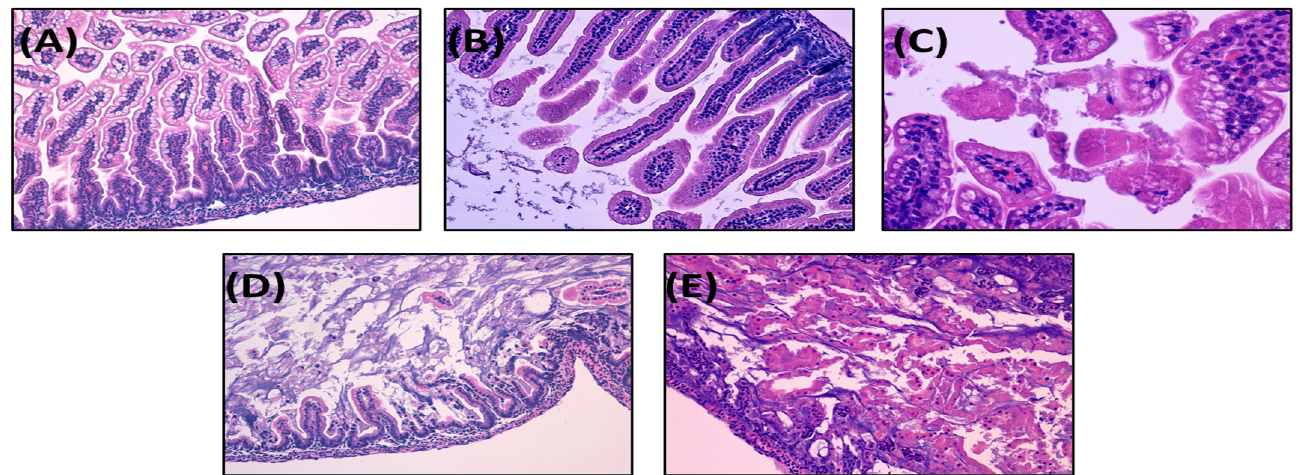
Figure 2. Histological grading of NEC severity in a NEC neonatal mouse model. Pups were subjected to NEC induction protocol and euthanized after 72 h or earlier in case of distress symptoms. Intestines were harvested, fixed in 10% formalin, and stained with hematoxylin–eosin. The severity of experimental NEC was classified from 0 to 4 according to a previously validated scoring system [66], as follows: ( A ) grade 0: intact villi; ( B ) grade 1: superficial epithelial cell sloughing; ( C ) grade 2: partially compromised villi structure, basal cells still present; ( D ) grade 3: complete villous necrosis, with basal cells still appreciable; ( E ) grade 4: transmural necrosis, basal membrane destroyed. Samples with histological scores of 2 or higher were considered positive for NEC. An injury score of 3 or 4 defines severe NEC. NEC: necrotizing enterocolitis. Image magnification 100×.